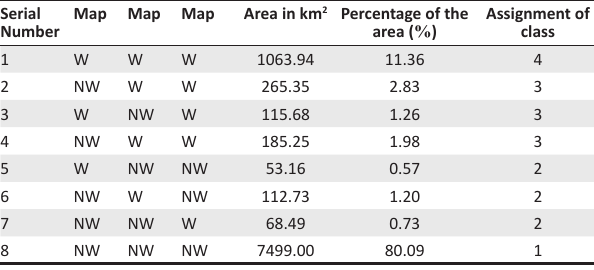
TABLE 2: Classification of flood-affected frequency. Serial Map Map Map Number